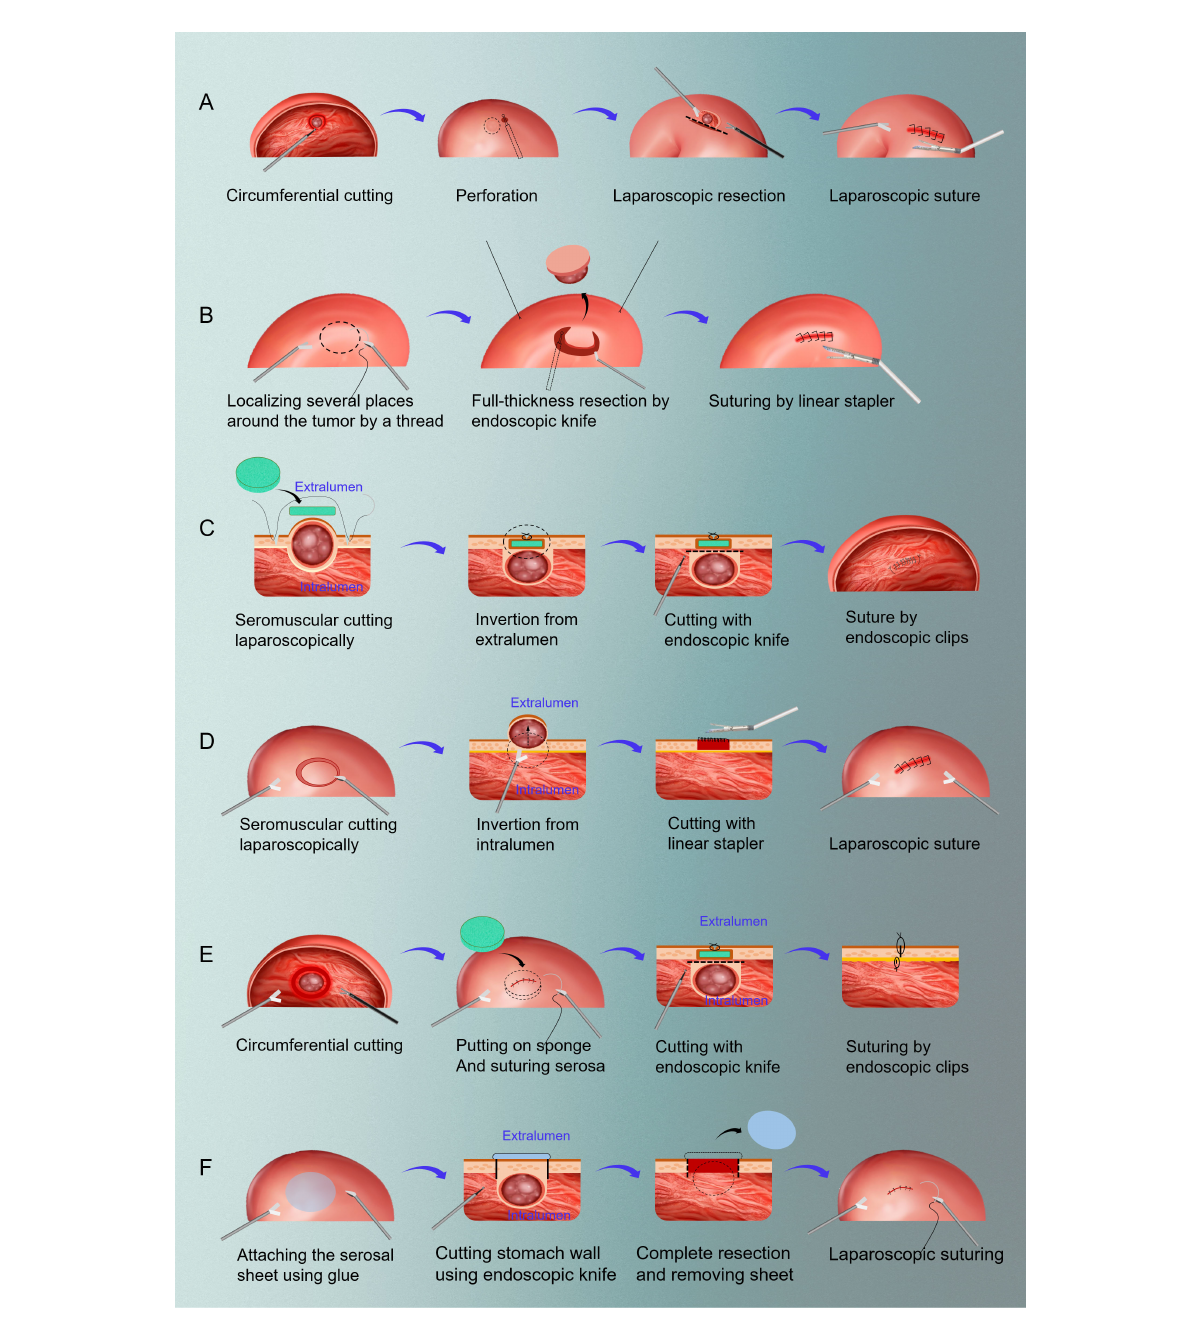
FIGURE 1 The schemas of six resection methods of LECS. (A) classical LECS; (B) inverted LECS (Crown Method); (C) NEWS; (D) CLEAN-NET; (E) closed LECS; (F) sealed EFTR. LECS, laparoscopic and endoscopic cooperative surgery; NEWS, non-exposure endoscopic wall-inversion surgery; CLEAN-NET, full-layer resection of gastric wall with non-exposure technique; EFTR: endoscopic full-thickness